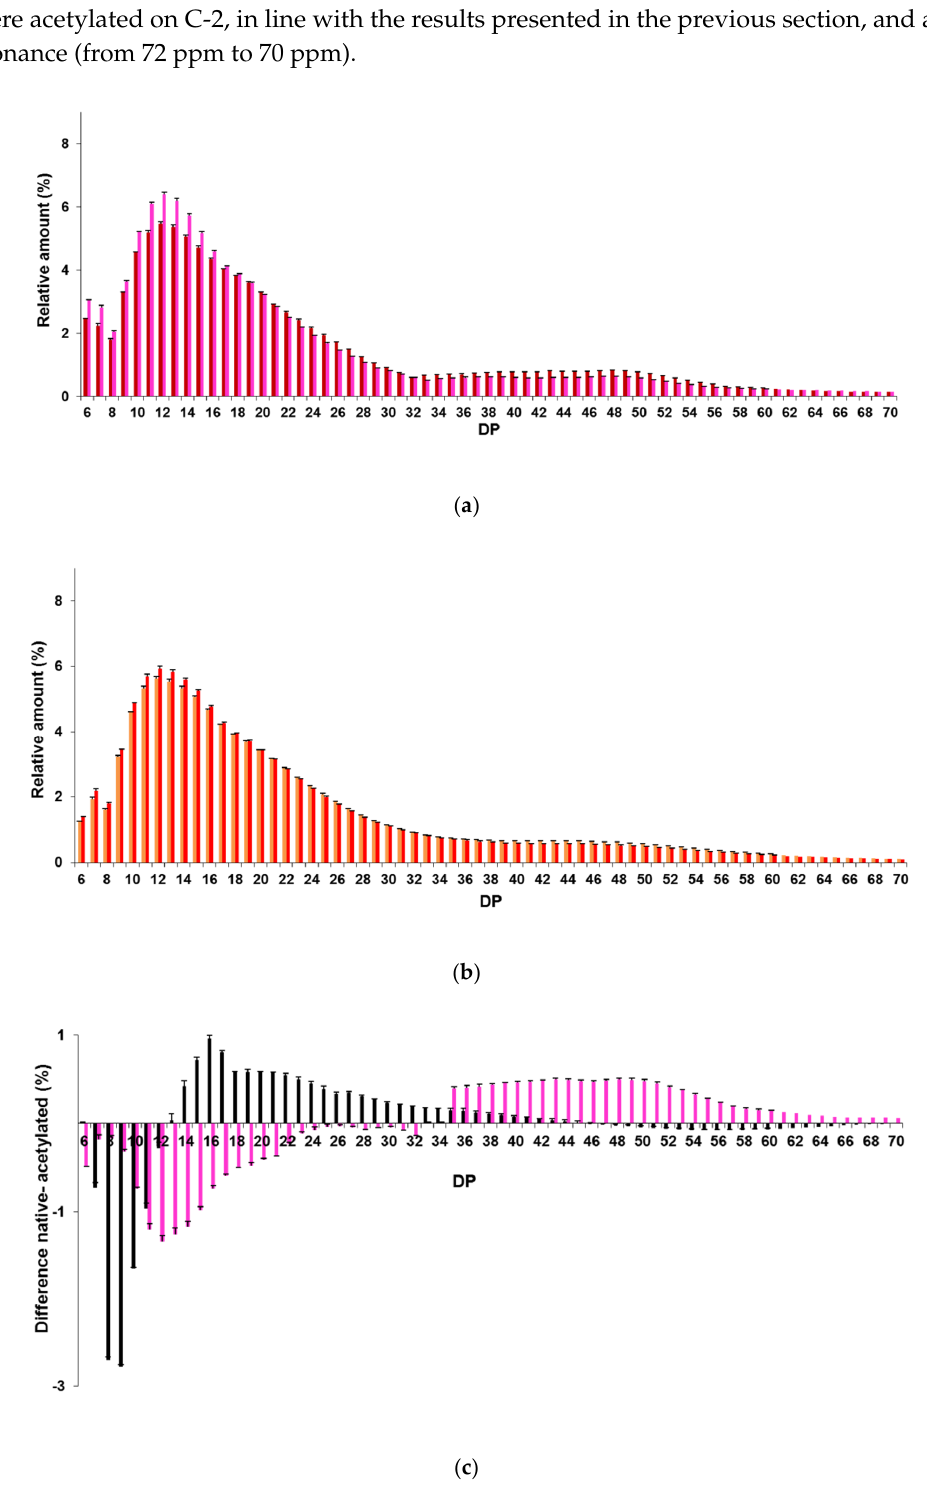
Figure 6. Chain length distributions of native and acetylated starches. ( a ) POS (dark red) and APOS (pink), ( b ) PES (Orange) and APES (Red), ( c ) difference of chain length between native and acetylated starches for AWMS (Black) and APOS (pink). Native waxy maize (WMS), potato (POS), pea (PES) starches and corresponding acetylated starches: AWMS, APOS and APES, respectively. The DS of AWMS, APOS and APES before deacetylation were 2.6, 2.4 and 0.7, respectively.